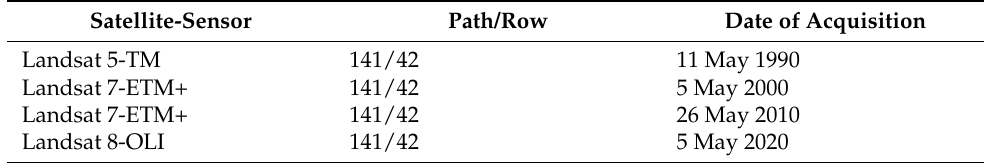
Table 1. Details of the data sets used in this study.